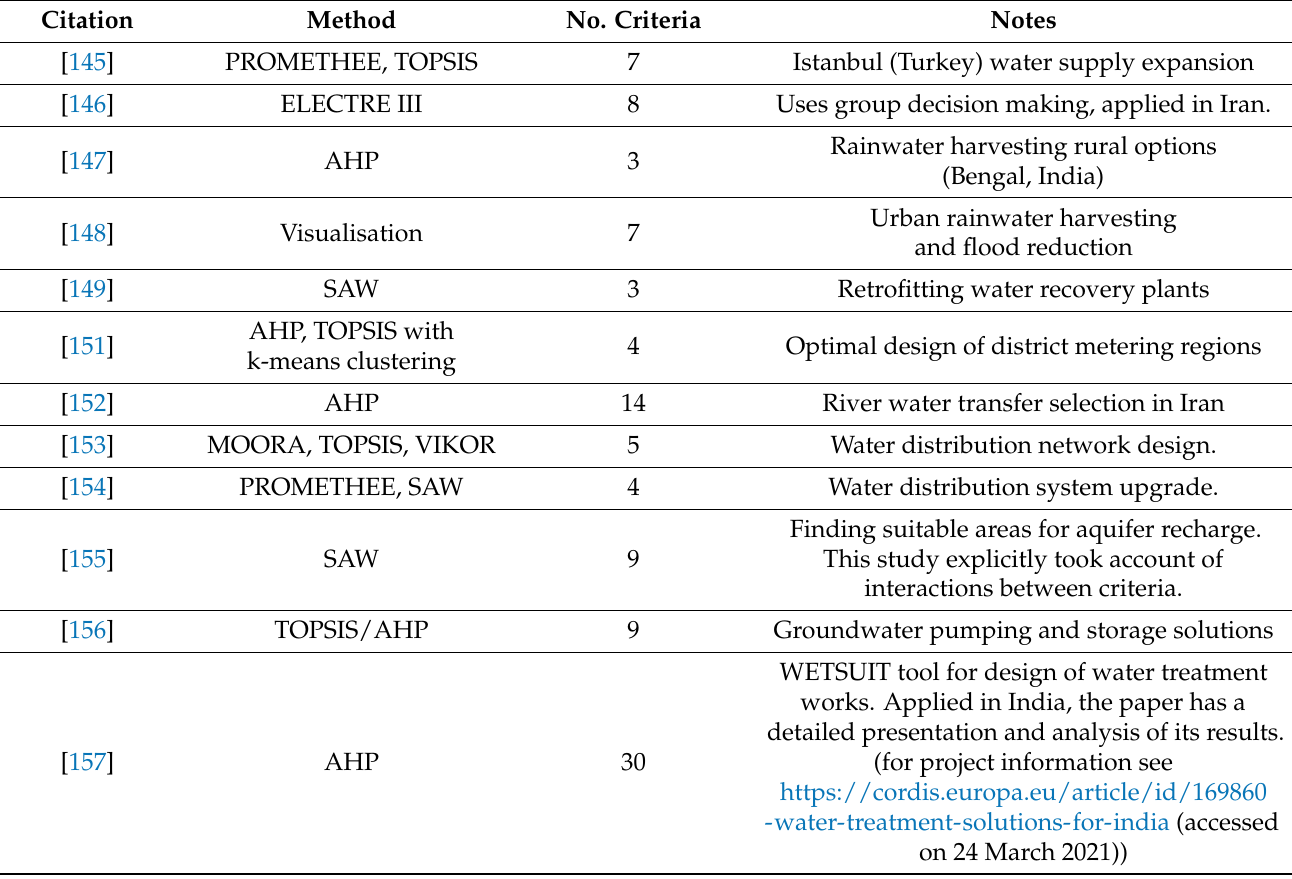
Table 13. Examples of the application of MCDA in water supply